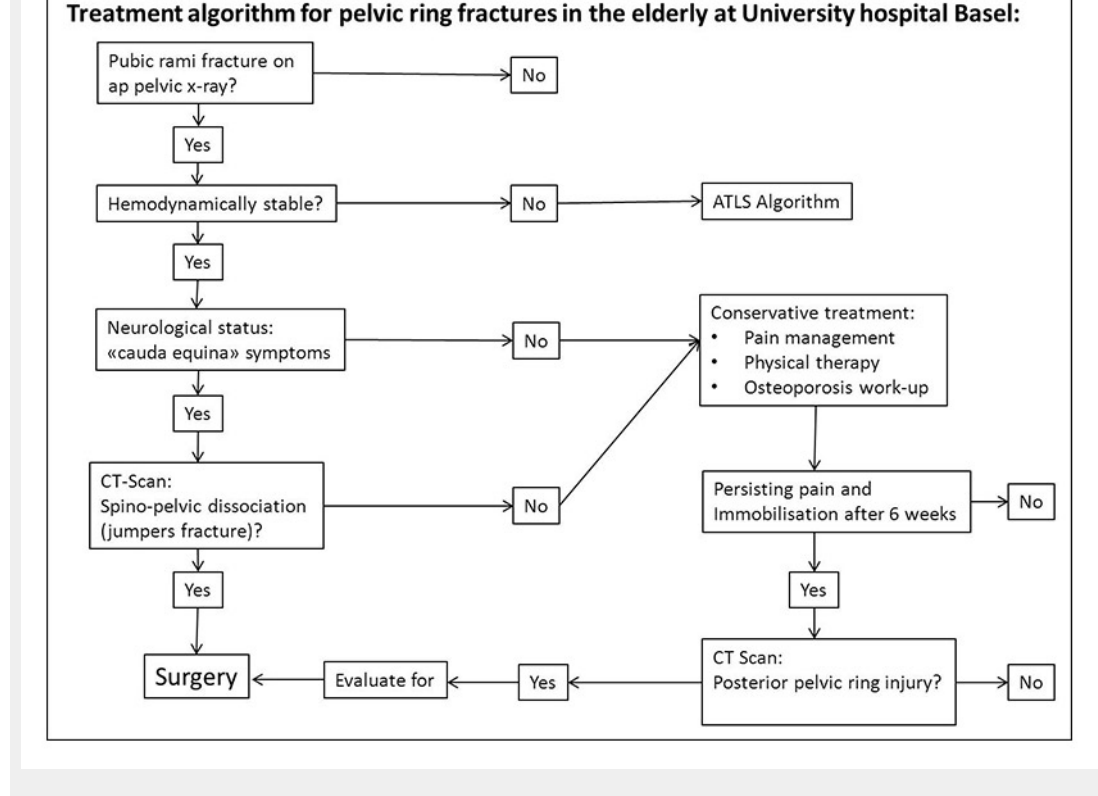
Currently used treatment algorithm for pelvic ring fractures in elderly